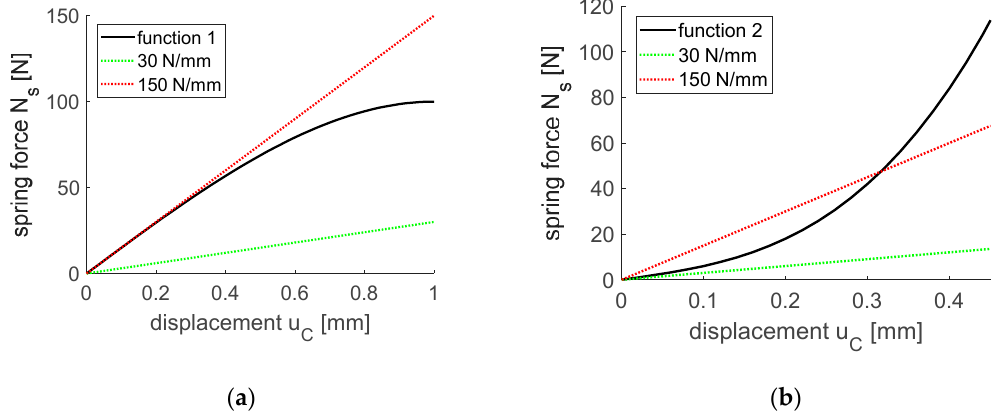
Figure 6. Nonlinear functions used to simulate the physical subsystem: ( a ) function (8), ( b ) function (9). Two alternative time courses of force F were taken into consideration and are presented in Figure 7.